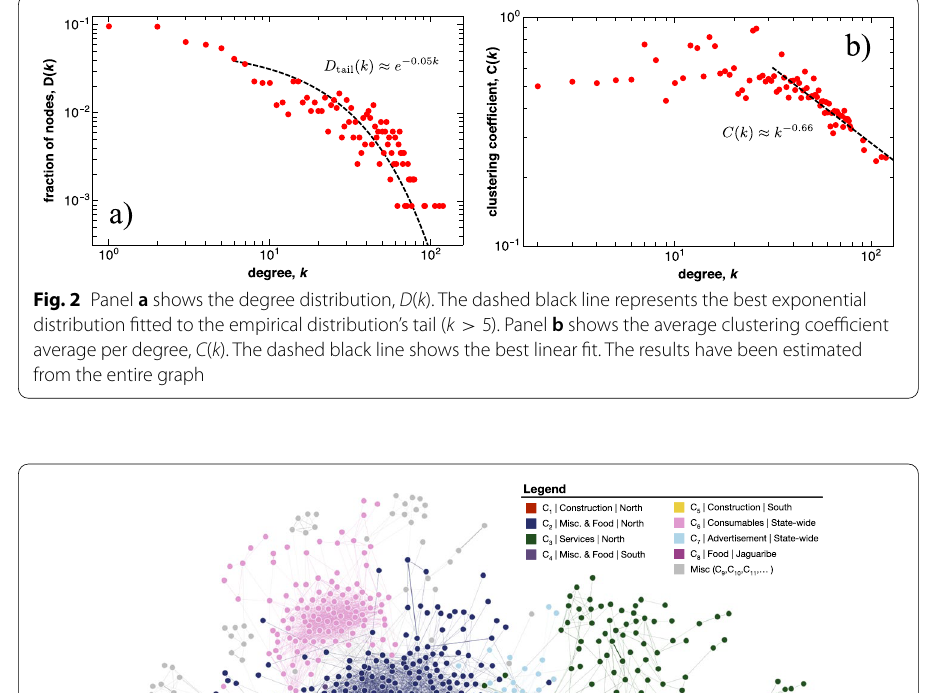
and can be explained by the fact that the network primarily represents competing firms that are specialized in supplying different services–works, goods, services, etc–in differ- ent regions. Hence, the most prominent communities divide the network into two major groups of firms that operate mainly in the northern (Red, Blue, and Green) and south- ern (Purple and Yellow) regions of the state of Ceará, but also on contracts that supply Food services (Blue and Purple) or construction works (Red and Yellow). Interestingly,